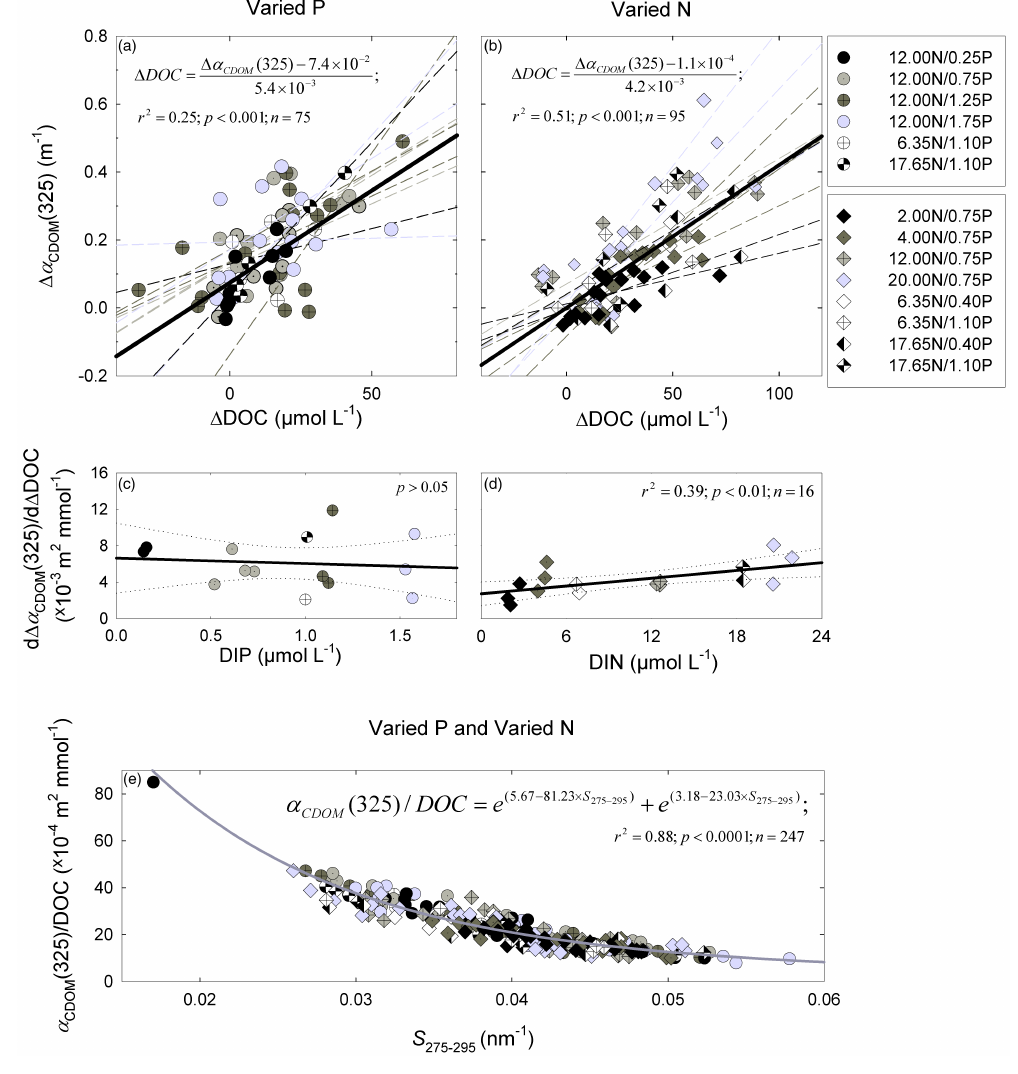
Figure 6. Regression plots of (cid:49) DOC against (cid:49)a CDOM (325) (a) during Varied P (shaded circles) and (b) during Varied N (shaded diamonds). The regression lines for each mesocosm are shown in dashed lines; thick black lines are regressions for all data from Varied P and Varied N respectively. The estimated slopes of regressions for each mesocosm from (a, b) are plotted as shaded circles for Varied P (c) and shaded diamonds for Varied N (d) . The thick black line is the linear regression line with 95% confidence interval (thin dotted lines). The estimated slopes covariance in Varied N to DIN initial supply can be expressed as d(cid:49)a CDOM ( 325 )/d(cid:49) DOC = 2 . 7 × 10 − 3 + 0 . 14 × 10 − 3 DIN (d) . Spectral slopes S 275 − 295 against a CDOM (325) /DOC for all mesocosms from both experiments are shown as shaded symbols (e) . The dark-gray line is the best fit to the data obtained in this